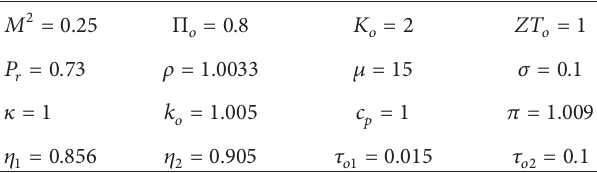
Table 1: The constants of the